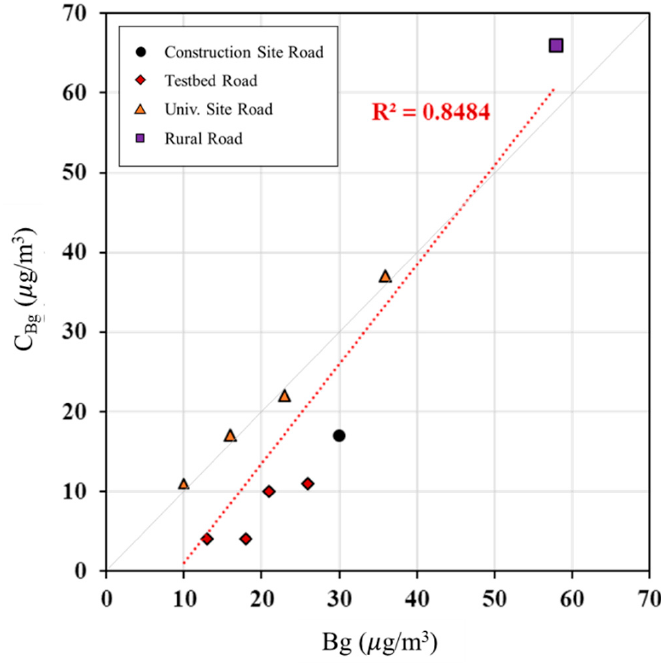
Figure 6. Compared concentration of Bg and C Bg on paved roads (without any